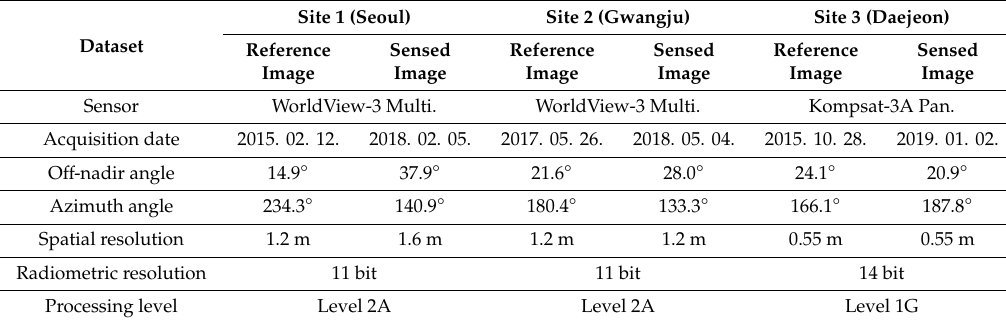
Table 1. Specification of constructed